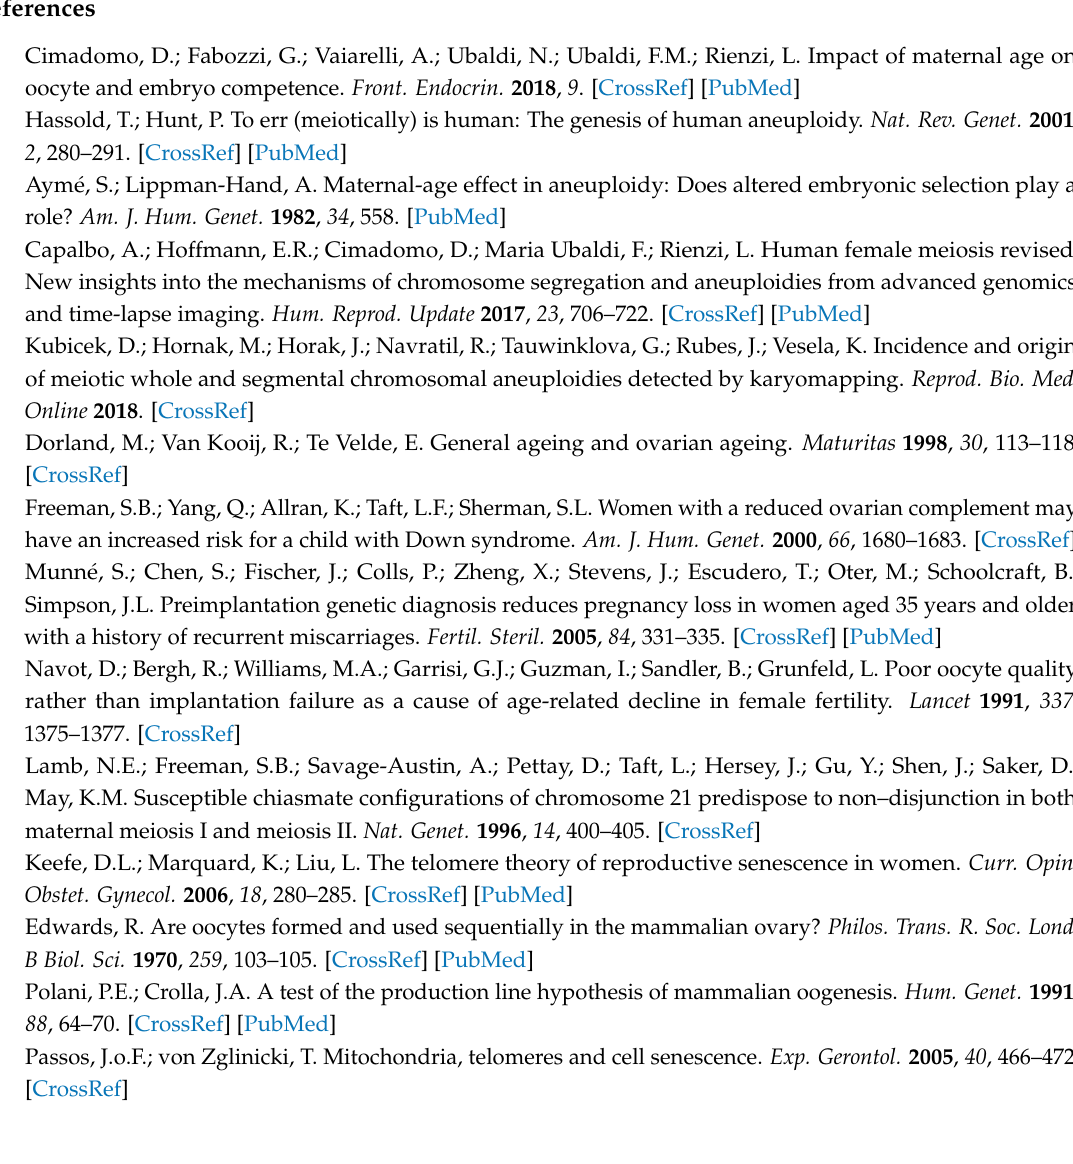
Supplementary Materials: The following are available online. Table S1: Anonymized patient details, and results of aneuploidy screening in first polar bodies following assessment, using the 24 Sure preimplantation genetic screening kit. ‘complex’ refers to aneuploid results involving four or more chromosomes, ‘n/a’ is not